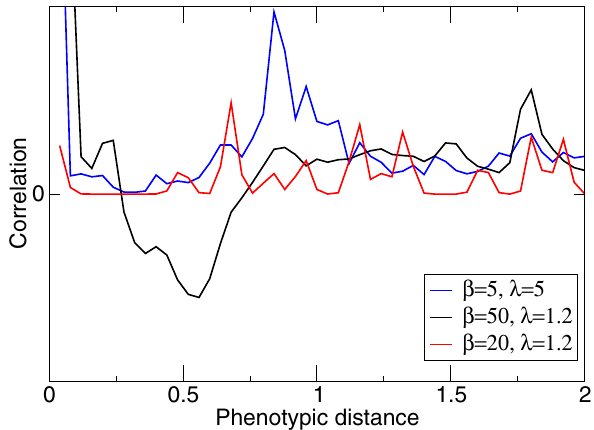
are arranged on a regular grid in phenotype space (see inset in